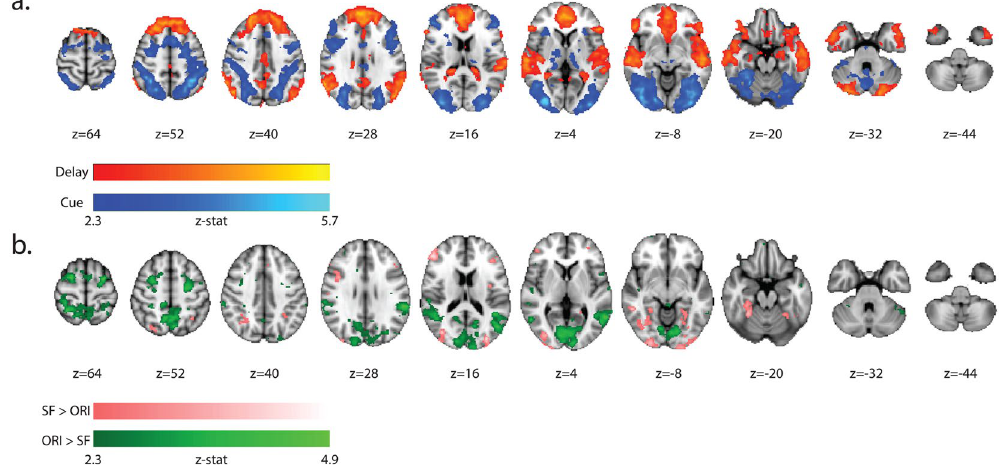
Figure 3. All colored areas represent z-values above 2.3 at a significance threshold of p corrected < 0.01. ( a ) Axial slices in MNI space depicting univariate contrasts for cue period > delay period BOLD in dark-to-light blue and delay period > cue period BOLD in red-to-yellow. ( b ) Axial slices in MNI space depicting univariate contrasts for cue period SF search task > Orientation search task in dark-to-light pink and cue period Orientation search task > SF search task in dark-to-light